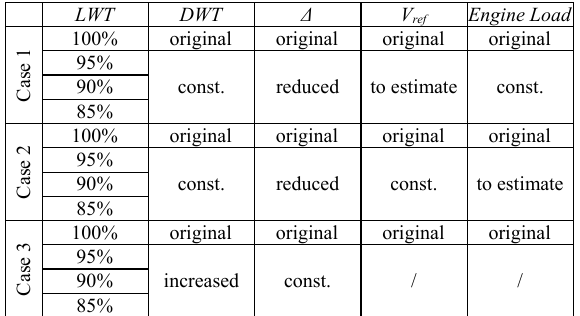
Table 3. Overall calculation